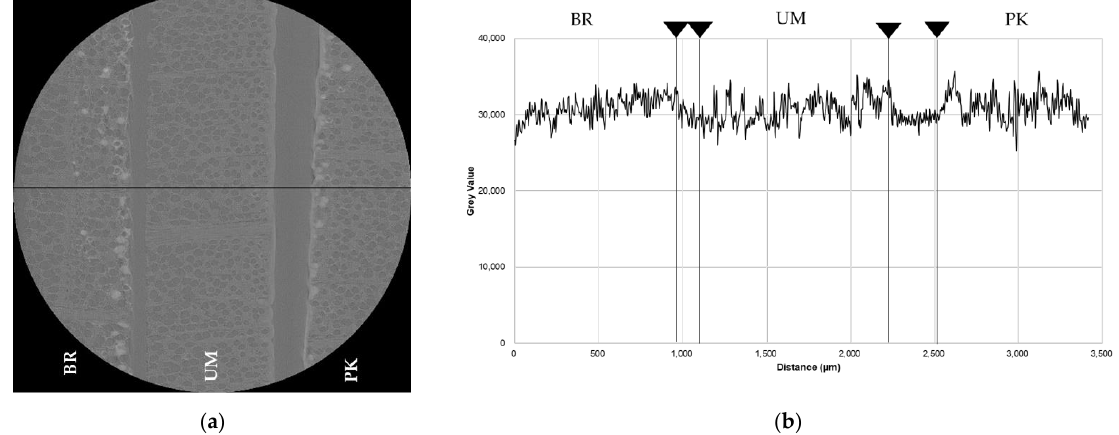
Figure 10. Sample series 1 Mo target with Al filter down side (BR, UM, PK); ( a ) visualization result and the plot profile line; ( b ) plot profile graphic.